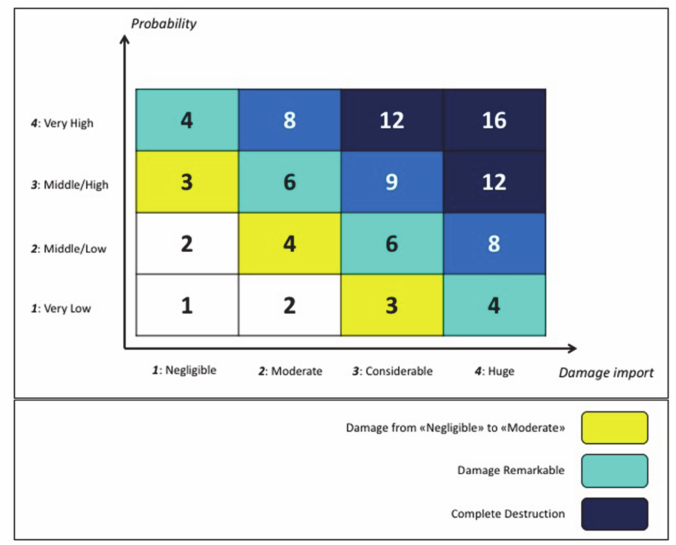
Figure 3. Map of the territories surrounding Mount Vesuvius, reporting fire risk areas (left) and farming activities classified according to the Fire Risk Assessment Matrix (right) (Source: FRAC program).